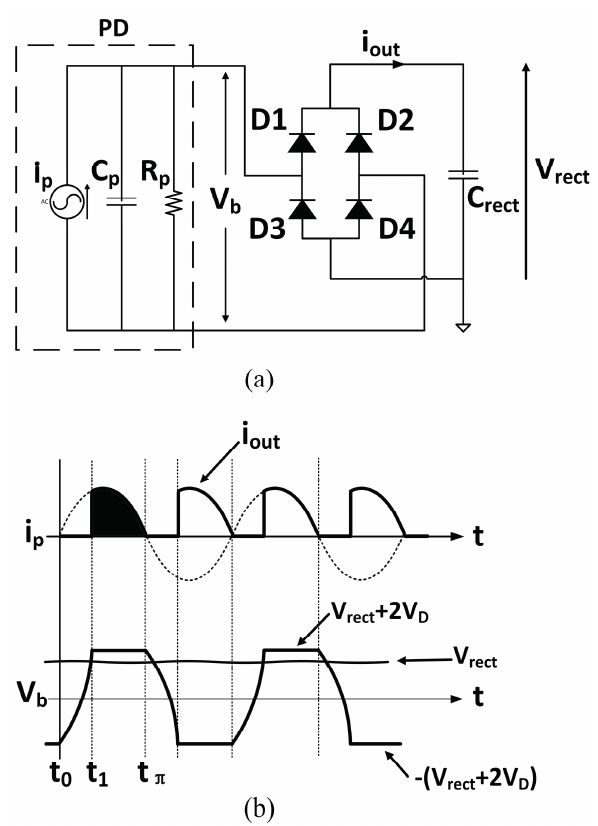
Figure 4. ( a ) Conventional full wave bridge rectifier; ( b ) Input and output